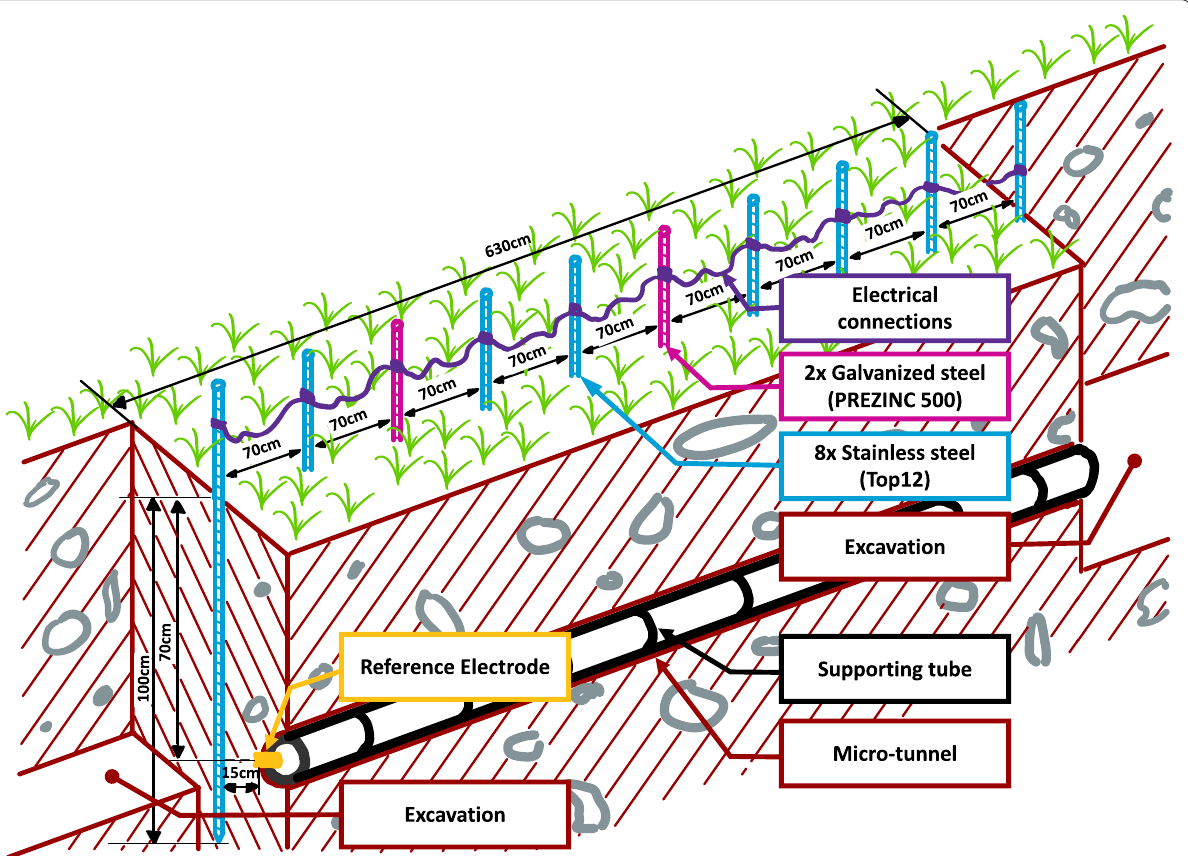
Fig. 8 Setup for the outdoor test of the developed underground corrosion detection system consisting of 10 bars equally spaced 70 cm apart from each other (8 rods 12% chromium steel Ø 16 mm and 2 galvanised steel rods Ø 14 mm), which forming a galvanic cell. A borehole was made = = between two excavations 6.3 m apart from each other at a depth of approximately 70 cm and 20 cm apart from the steels and parallel to